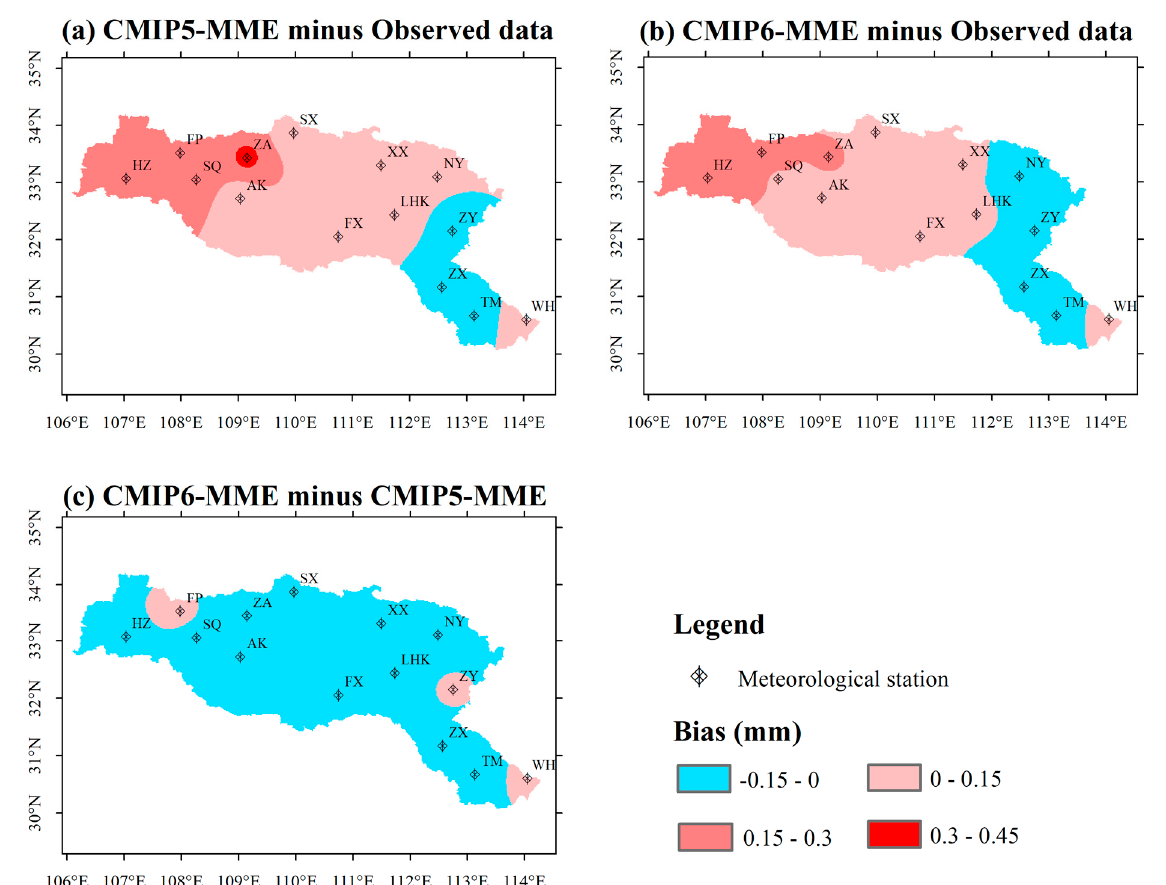
Figure 7. Daily precipitation biases ( a ) between CMIP5-MME downscaled data and observed data, ( b ) between CMIP6-MME downscaled data and observed data, and ( c ) between CMIP6-MME and CMIP5-MME downscaled data over HRB.